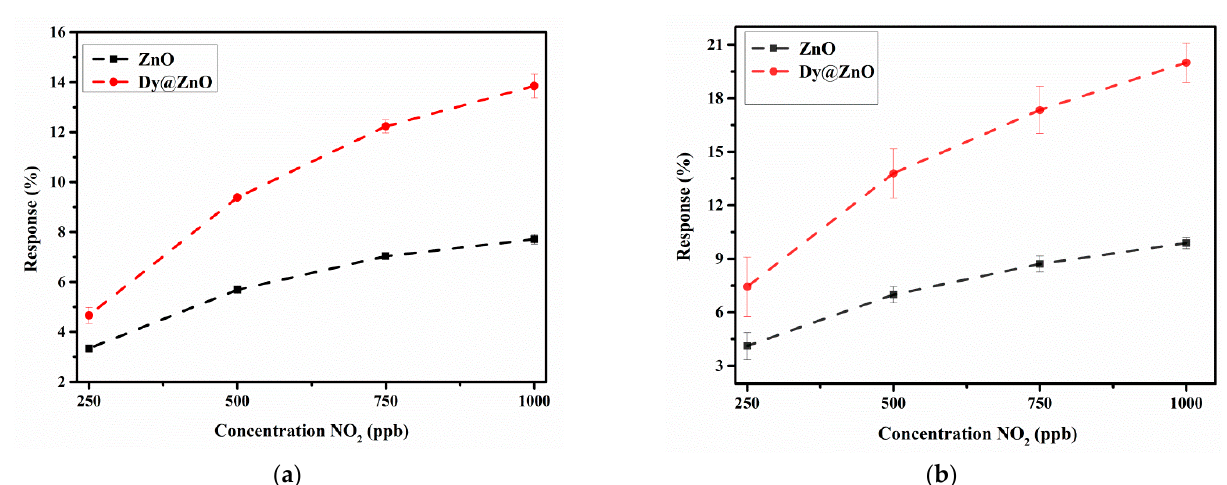
Figure 8. The response of the sensors as a function of concentration NO 2 in dry conditions ( a ) and humid conditions ( b ). The sensor responses were defined as ∆ R/R a expressed in percentage.